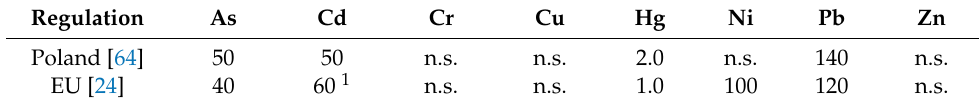
Table 3. PTE limit values in mineral fertilizers according to Polish and EU regulations, mg · kg − 1 DM. Regulation As Cd Cr Cu